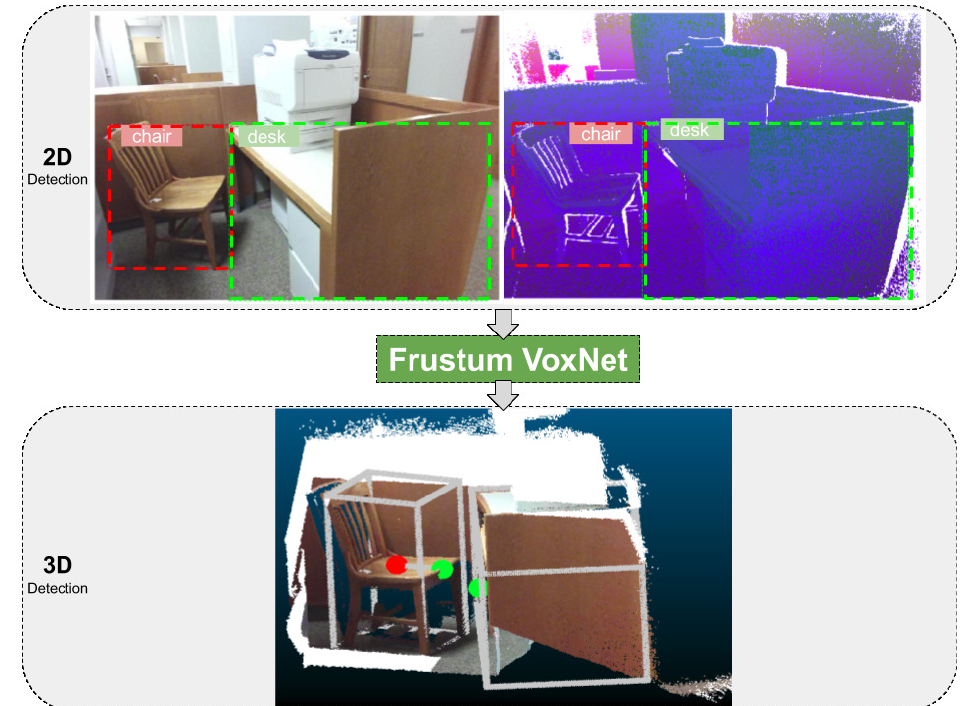
Figure 1. Overview of the whole system. Upper left: RGB image and detected 2D bounding boxes. Upper right: depth height and signed angle (DHS) image, and detected 2D bounding boxes. A DHS image is a pseudo-RGB image generated by a depth image (see text). Bottom: The final 3D detected objects from the associated 3D range image. The 3D detection not only provides an amodal bounding box but also an orientation. The red point is the center of the bounding box and the green one is the front center. The detected 2D bounding boxes from either and RGB or DHS image, generate 3D frustums (which are prisms having as apex the sensor location and extend through the 2D bounding boxes to the 3D space). They are then fed to our Frustum VoxNet network, which produces the 3D